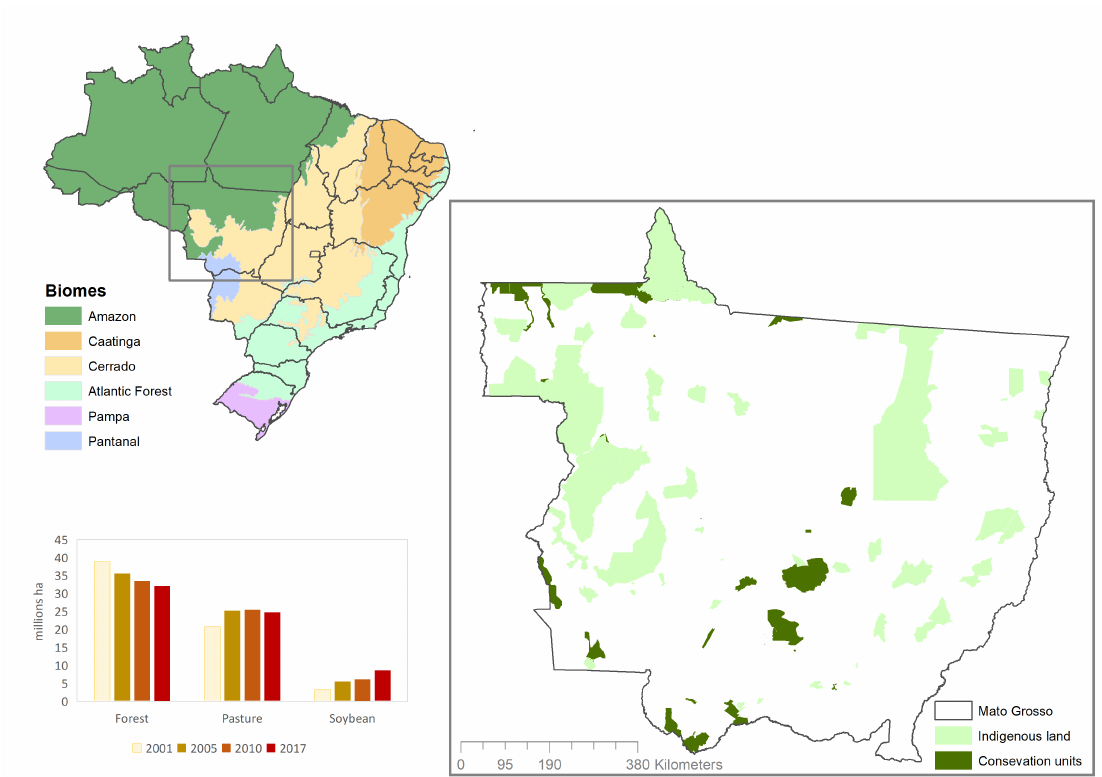
Figure 1. Left: Location of the State of Mato Grosso relative to Brazil and its biomes. Right: Indigenous lands and conservation units in the State of Mato Grosso. Chart: Forest, pasture, and soybean area in the State of Mato Grosso. Source: Chart based on Camara et al. [21]